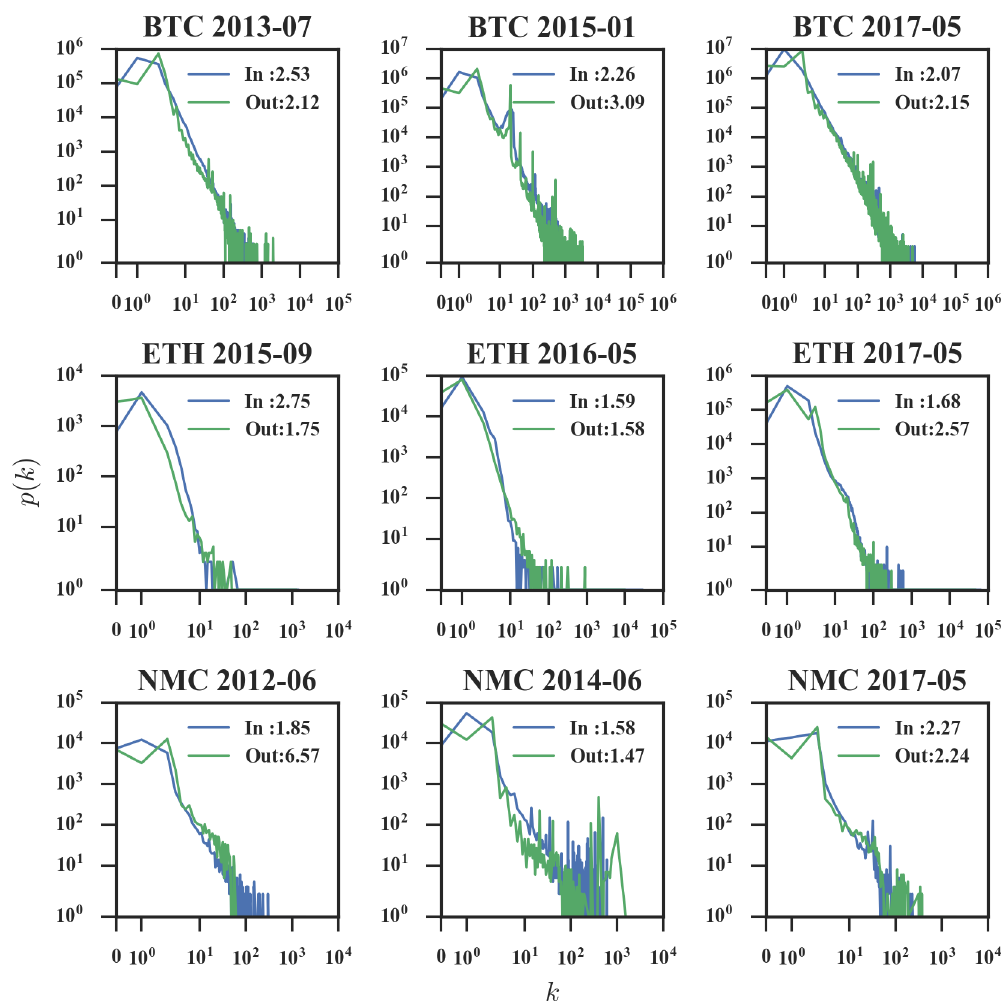
Fig 6. Samples of degree distributions of monthly networks. Data are sampled from Bitcoin (top row), Ethereum (middle row), and Namecoin (bottom row). Example data for power-law fitting are approximate fit (first column), poor fit (medium column), and inconsistent fit (last column). The legends show the fitting exponent γ in p ( k ) * k − γ with respect to indegree and outdegree